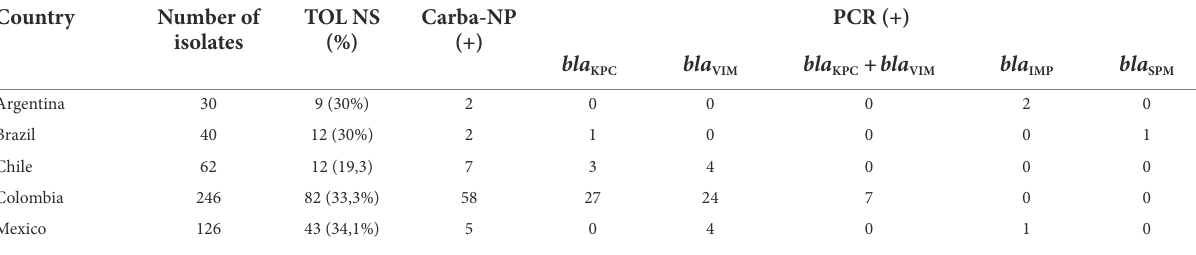
TABLE 1 Phenotypic and molecular screening of carbapenemases in 74 TOL non-susceptible clinical isolates of Pseudomonas aeruginosa from 5 Latin American countries. Country Number of TOL NS isolates